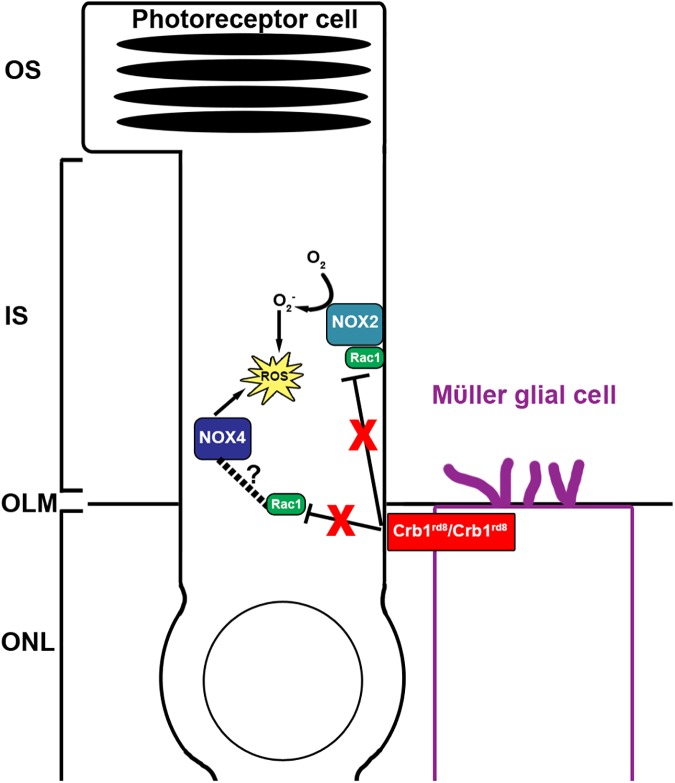
Crb1 in hyperoxia-induced proliferative retinopathy (HIPR) model.Crb1, located at the subapical region of the outer limiting membrane on Mϋller cells, connects Mϋller cells to photoreceptors. With the rd8 mutation, Crb1 no longer regulates (inhibits) Rac1. Uninhibited Rac1 then activates NOX2 to produce superoxide. Superoxide is reactive oxygen species (ROS). It is unknown what mechanism regulates NOX4. We hypothesize (dotted line) that in photoreceptors, NOX4 is activated by a Rac1-dependent signaling mechanism. In turn, with loss of Crb1 regulation of Rac1, an increase in NOX4 produces more ROS, leading to photoreceptor damage via oxidative stress.